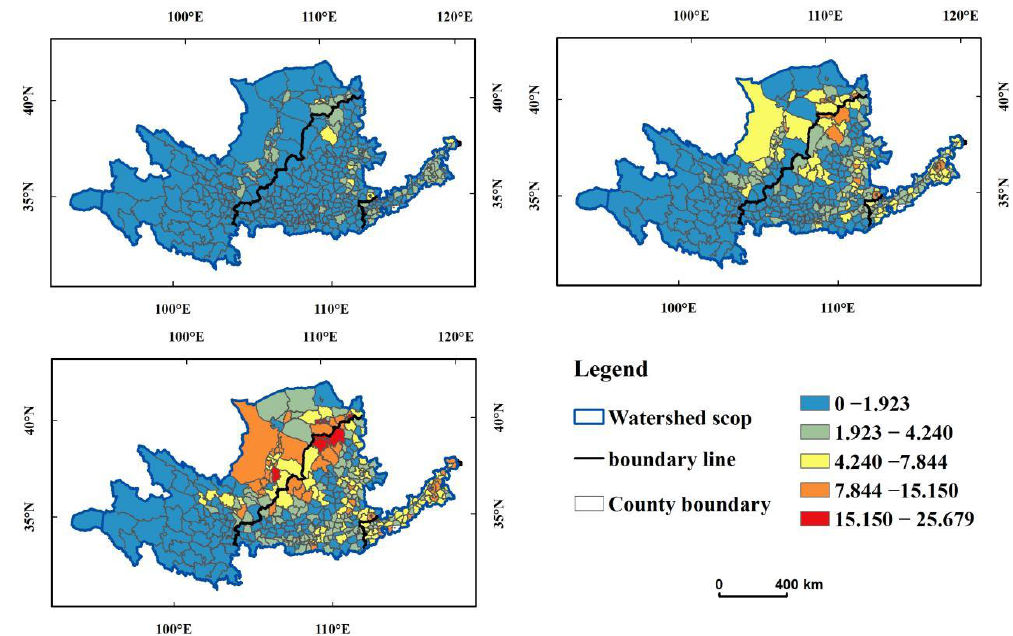
districts) such as Wanrong, Yongshou, Lingtai, Longde, and others. The subhot spots Figure 5. Distribution trend of carbon emissions in different streams of the YRB. shrank, while the subcold spots expanded. The local spatial autocorrelation module of ArcGIS was used to calculate the local indexes of carbon emissions in the YRB from 2000 to 2020, and spatial cluster maps were drawn (Figure 6). From 2000 to 2020, the hot spots in the middle and upper reaches of the YRB expanded to the southern Loess Plateau, while those in the lower reaches concentrated in the coastal areas; cold spots were confined to the southwest. In 2000, hot spots were concentrated in Inner Mongolia and Ningxia of the upper reaches and Shandong Henan of the lower reaches. The hot spots in the upper reaches involved 18 counties (cities and districts) and in the lower reaches involved 48 counties (cities and districts) such as Fengqiu, Yanjin, Dongping, and Zouping (Figure 6). Moreo- ver, there were three small-scale hot spots in the middle reaches in Shanxi Province. Cold spots of carbon emissions were concentrated in Qinghai, Gansu, and Shaanxi provinces, including 136 counties (cities and districts) of Yongjing, Guide, Taibai, and Heshui, which are at the transition from the Qinghai – Tibet Plateau to Loess Plateau. Subhot spots sur-